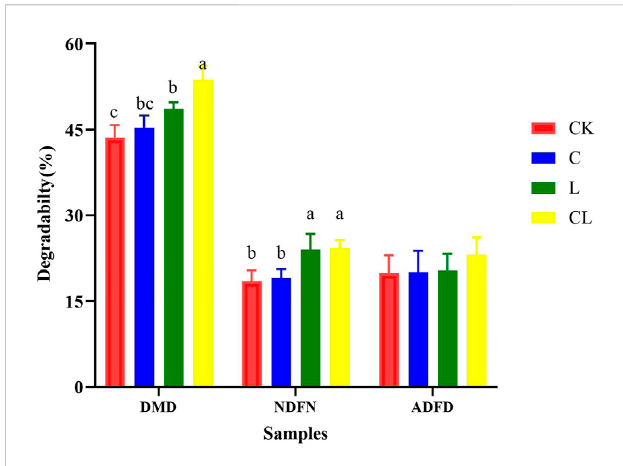
FIGURE 8 The nutrient degradation rate in Caragana korshinskii silage after 72 h in vitro rumen